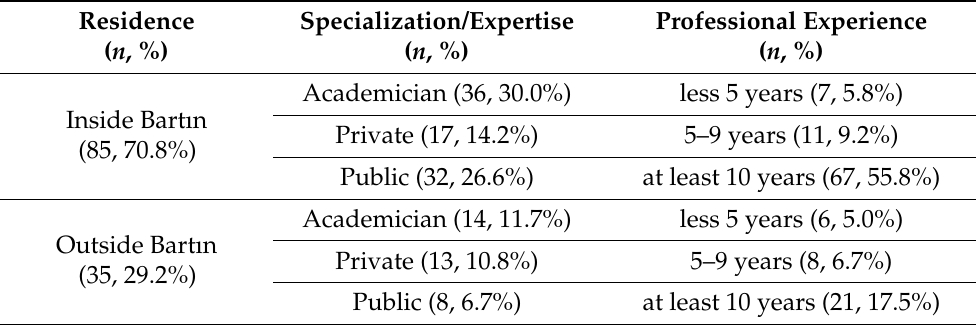
Table 3. Field expertise of the participants in terms of